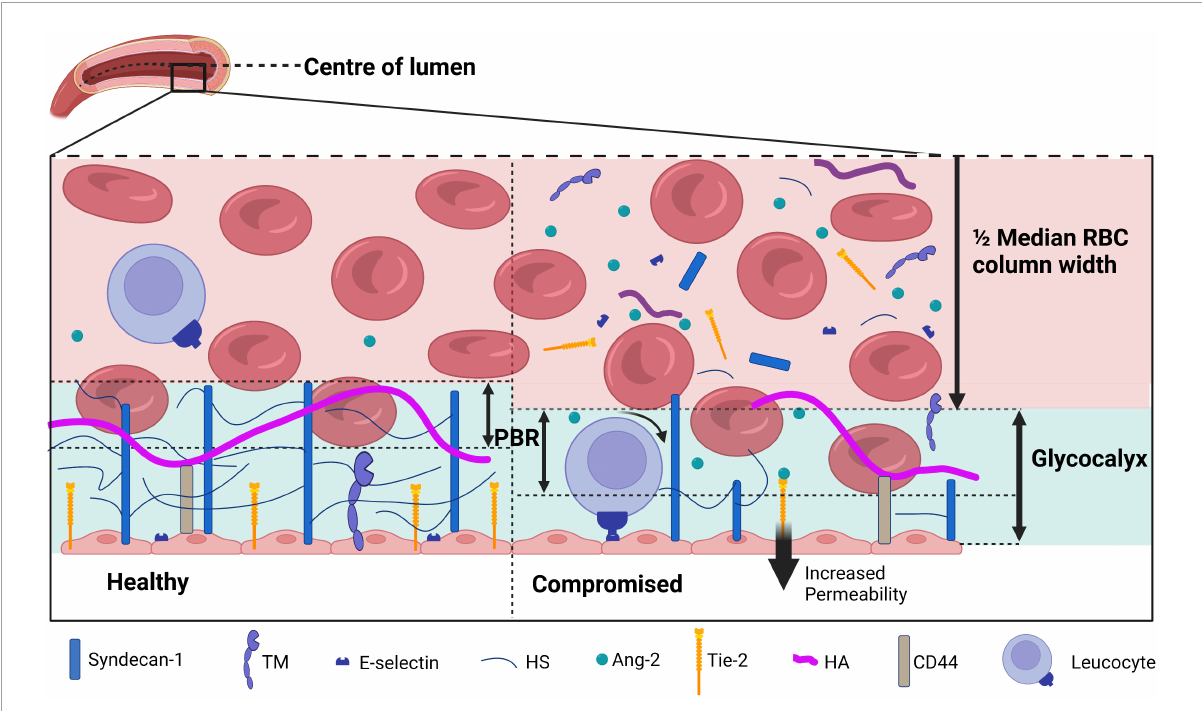
FIGURE2 A schematic overview of the glycocalyx under physiological (left) and diseased (right) conditions covering the endothelial cells in the lumen of a blood vessel. The perfused boundary region (PBR) is defined as the distance between the median red blood cell (RBC) column width and the limit where erythrocytes can be found. During physiological conditions, the glycocalyx is composed of syndecan-1 and glycosaminoglycans including heparan sulfate (HS) and hyaluronan (HA). Receptors such as thrombomodulin (TM), Tie-2, and E-selectin are present on the endothelial membrane. During disease, the glycocalyx is damaged and components are shed to the plasma, which causes an increase in the PBR as erythrocytes are able to penetrate deeper in the glycocalyx layer. Activation of endothelial cells causes both activation and release of surface receptors TM, Tie-2, and E-selectin. E-selectin activation increases leukocyte rolling, increased Ang-2 levels binding to Tie-2 increases vessel permeability. Figure created with